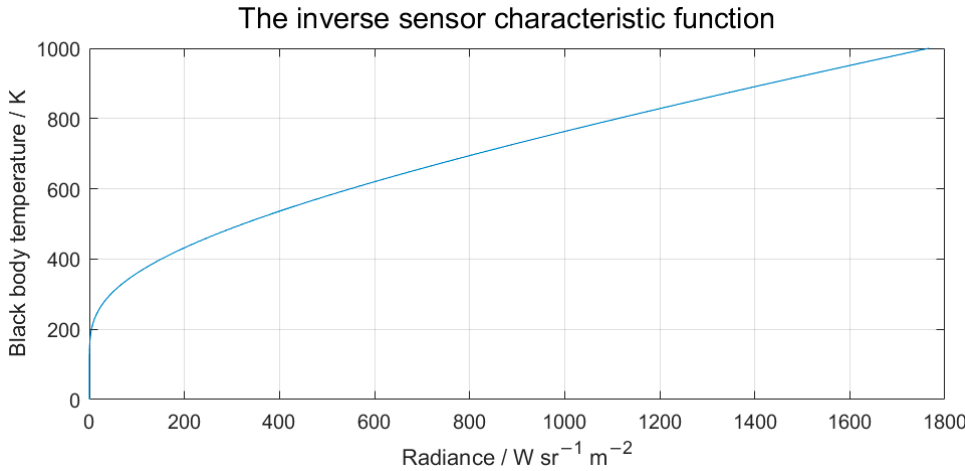
Figure 11. The inverse characteristic function of a VOx sensor. The characteristic is obtained by in- verting the characteristic function of the sensor from Equation (13) and Figure 6. inverting the characteristic function of the sensor from Equation (13) and Figure